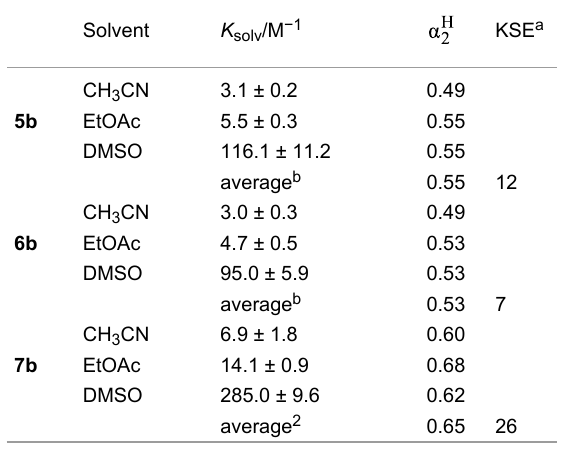
Table 2: FTIR measured equilibrium constants at 298 K for H-bonding of solvents with selected antioxidants ( K solv ) and corresponding values calculated by Equation